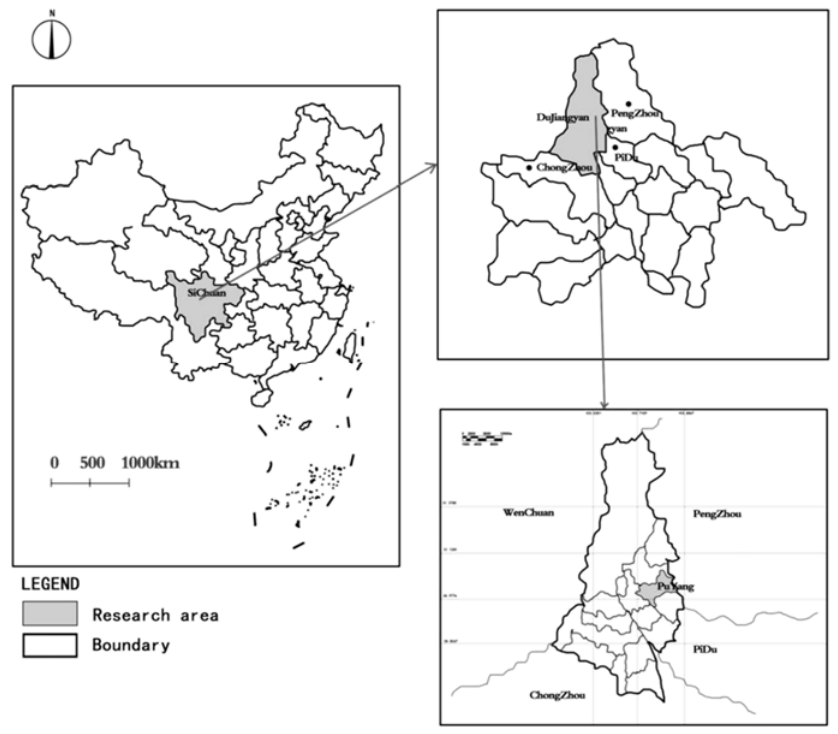
Figure 2. Survey area location.